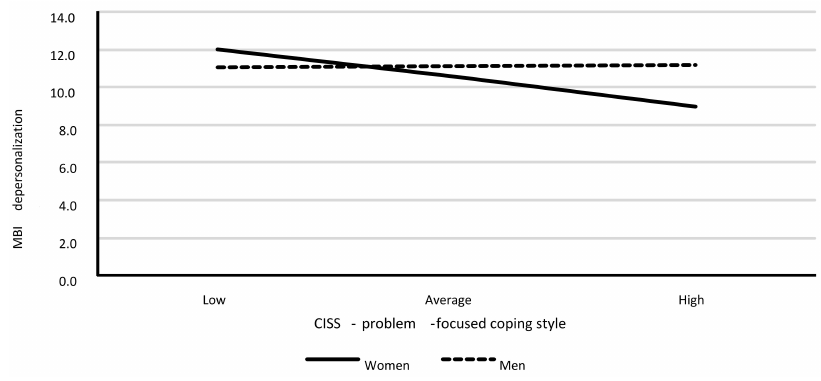
Figure 3. Associations between PFS and depersonalization, separately for both genders. Model 4. The moderating role for the association between person-oriented avoidance (POA) and